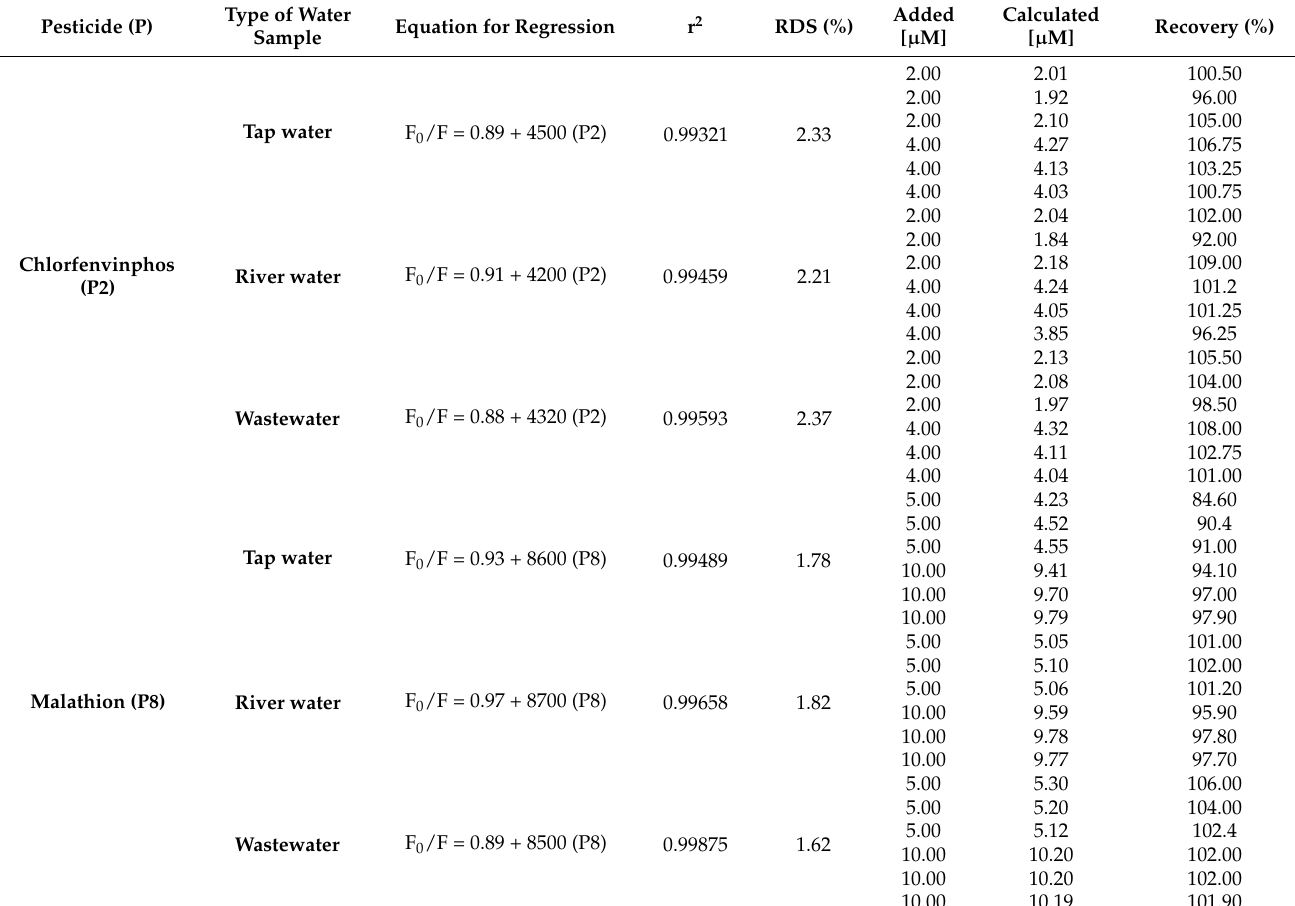
Table 6. The recovery data of chlorfenvinphos and malathion in various water